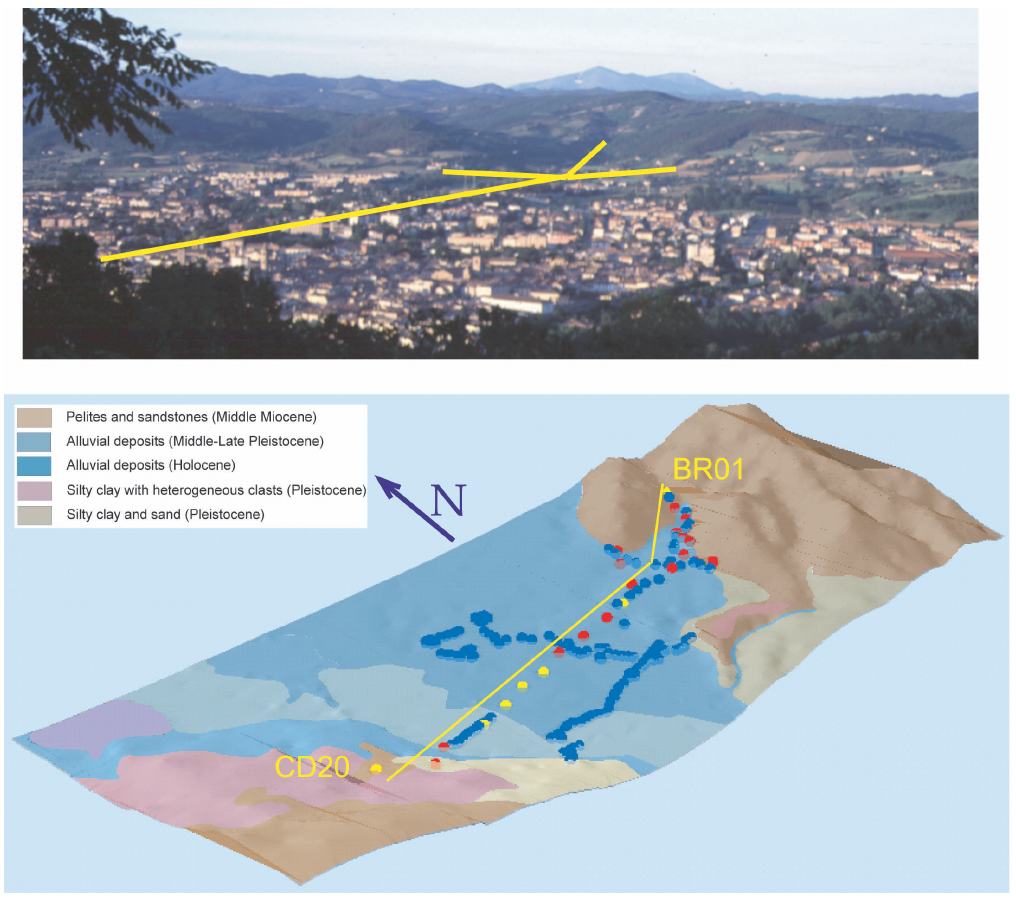
Fig. 2a. Top panel shows a panoramic view of Città di Castello town with the array position (yellow lines); note the high urbanization. Bottom panel shows topography and geology of the study area. Red and yellow dots are sites of the array stations; blue dots show noise measurements sites. The yellow line is the trace of the topo- graphic profile in fig.